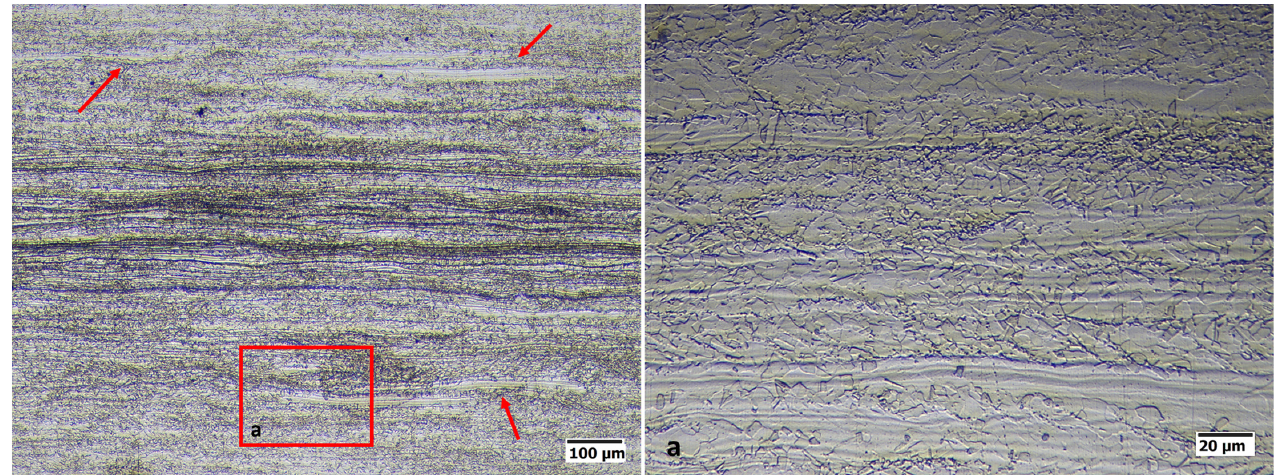
Figure 5. AISI 904L steel after cold rolling at 50% and annealing at 950 °C for 180 s (red arrows indicate the partially recrystallized areas).